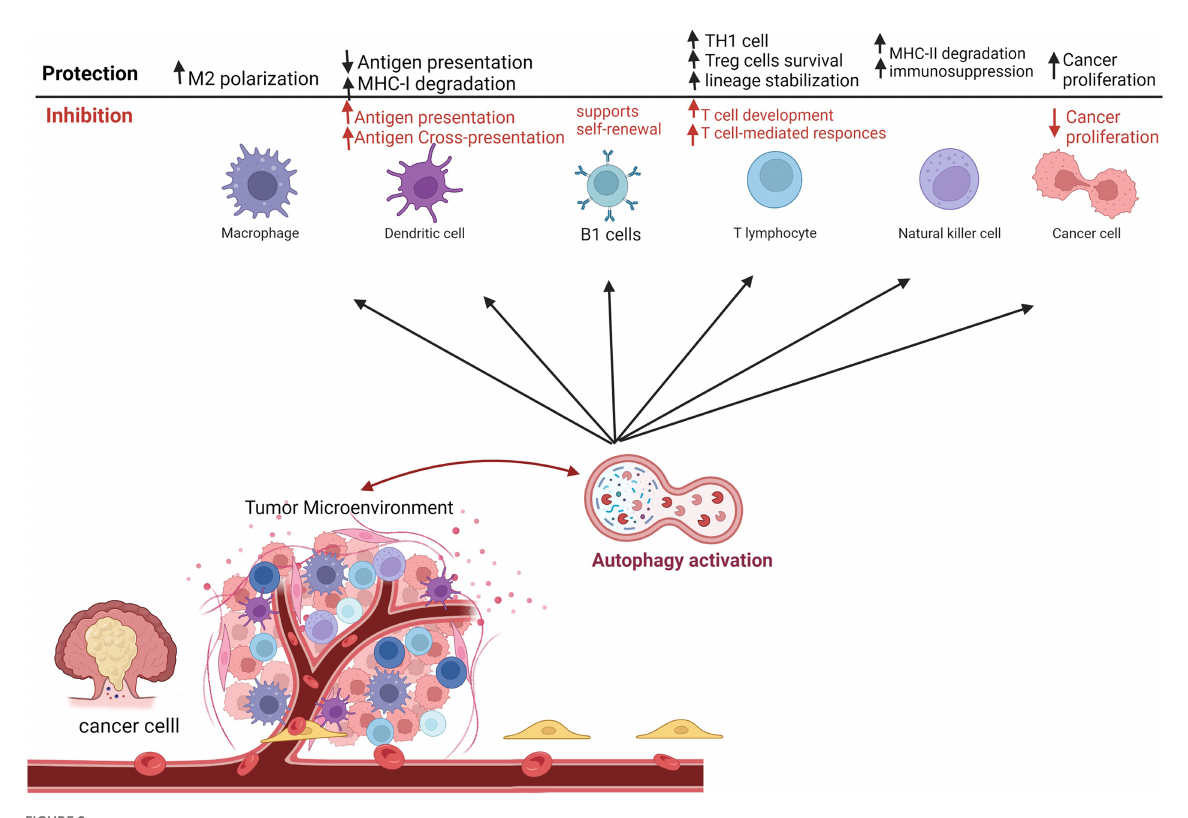
FIGURE2 Autophagy roles in immune responses as a tumor-suppressive and tumor protective mechanism in the tumor microenvironment. This figure was modified from Zada et al.